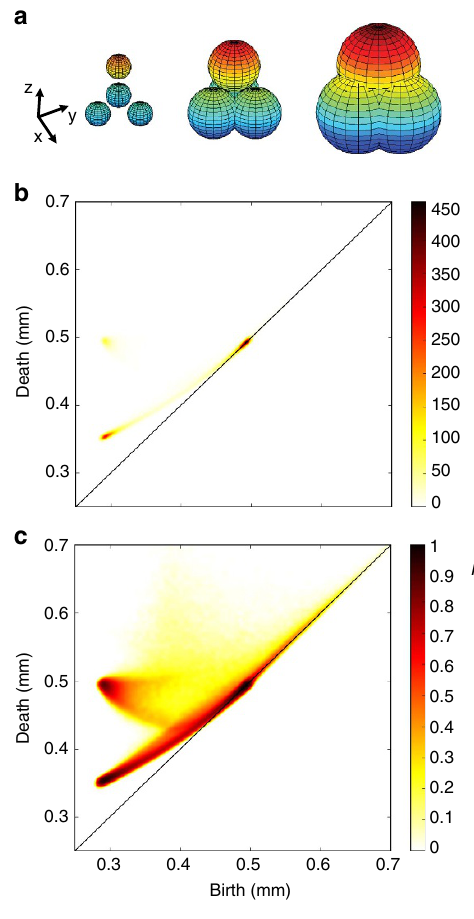
Figure 2 | Persistence diagrams. ( a ) Tetrahedral configuration of mathematical balls with growing radius a . Colour changes from blue to red with increasing z value. ( b ) Persistence diagram PD 2 as a probability density function of pores indicating via the colour map the occurence rate P of a given grain configuration at a specific ( b , d ) pair. PD 2 is plotted for a packing with a density of f ¼ 0.685. ( c ) PD 2 for the same packing, the rate of occurence is now expressed in terms of the frequency index I f ¼ log((log( P þ 1)) þ 1)/ I fM to highlight the fine details of the